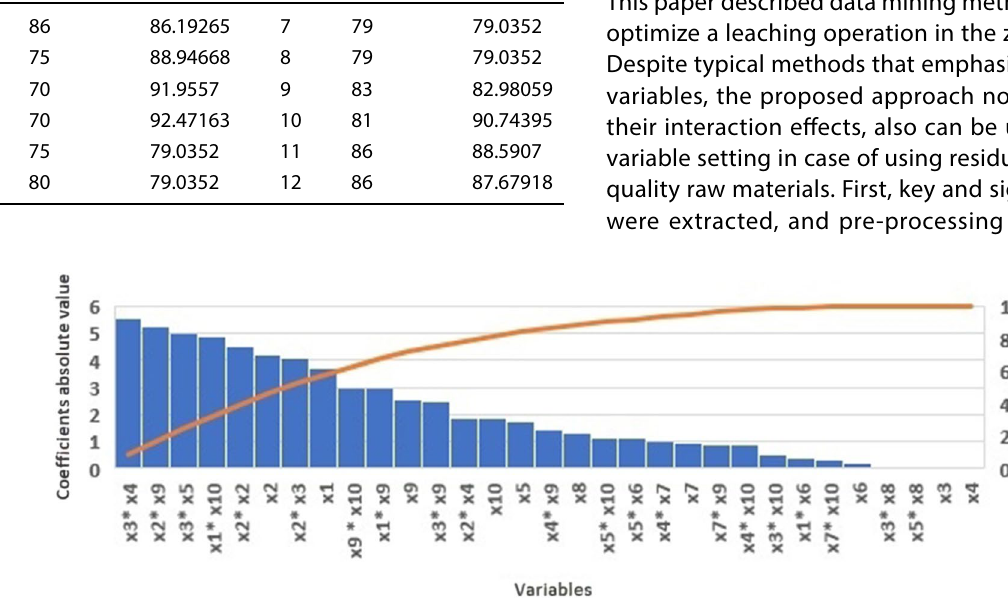
Fig. 10 The Pareto diagram of the coefficients’ absolute value for the second